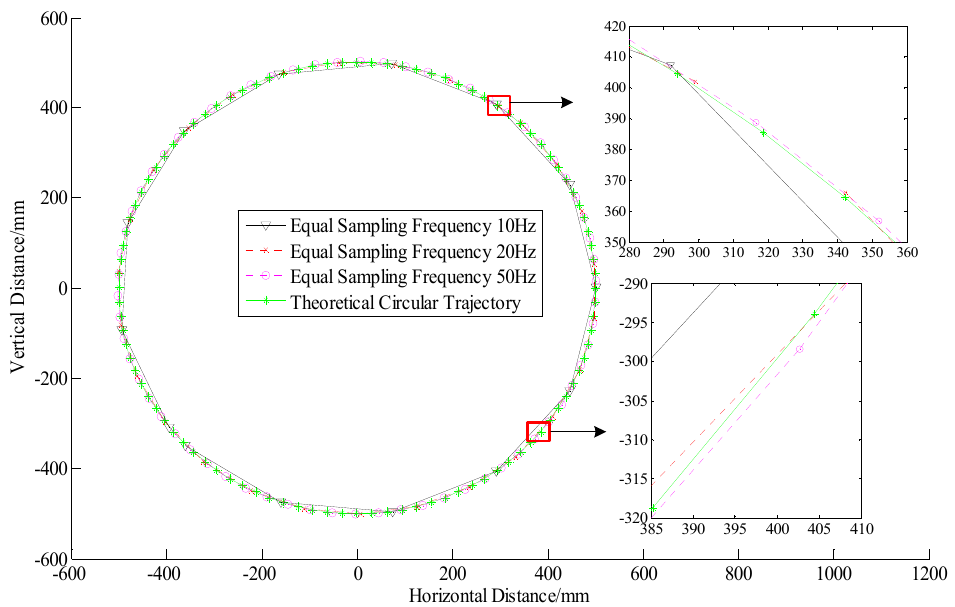
Figure 9. Projection position of the sampling points with different measurement frequencies—(D = 1 m).